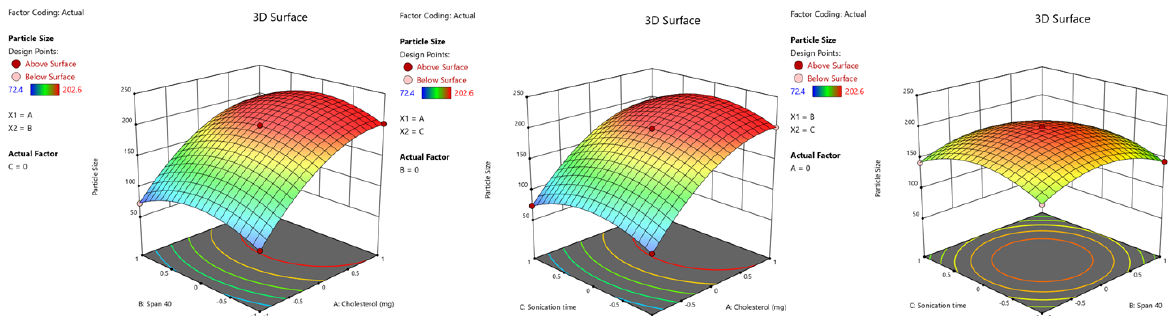
Figure 1. 3D surface response plots of the effect of factors on particle size.